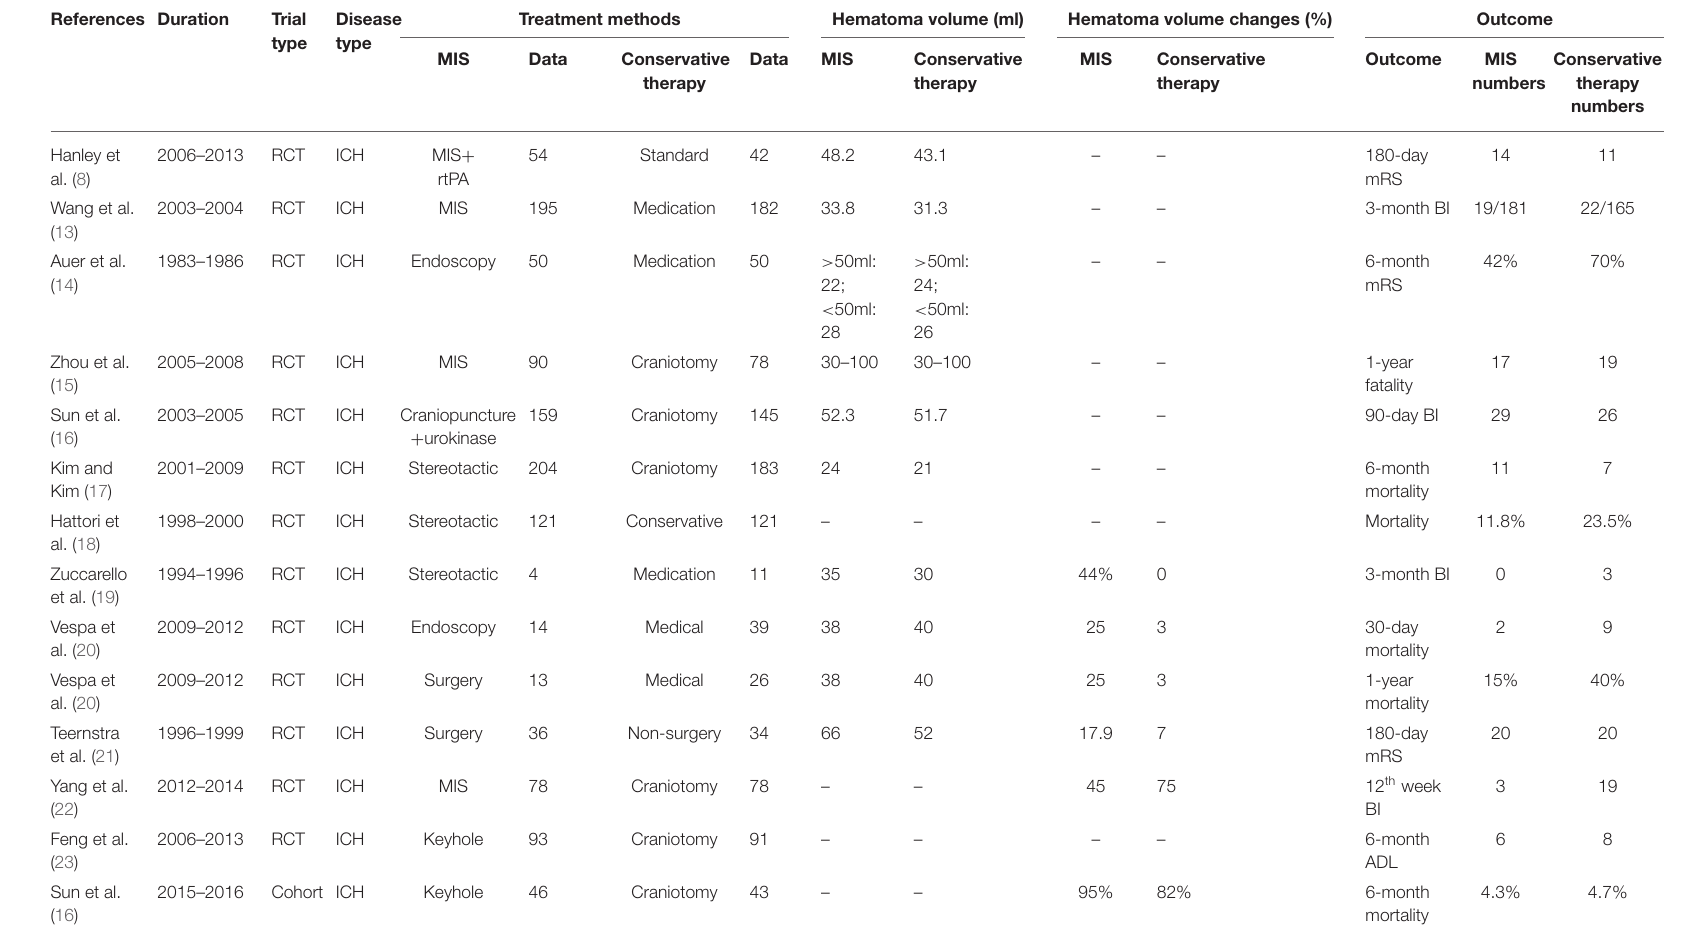
TABLE 1 | Characteristics of the related studies including RCTs and